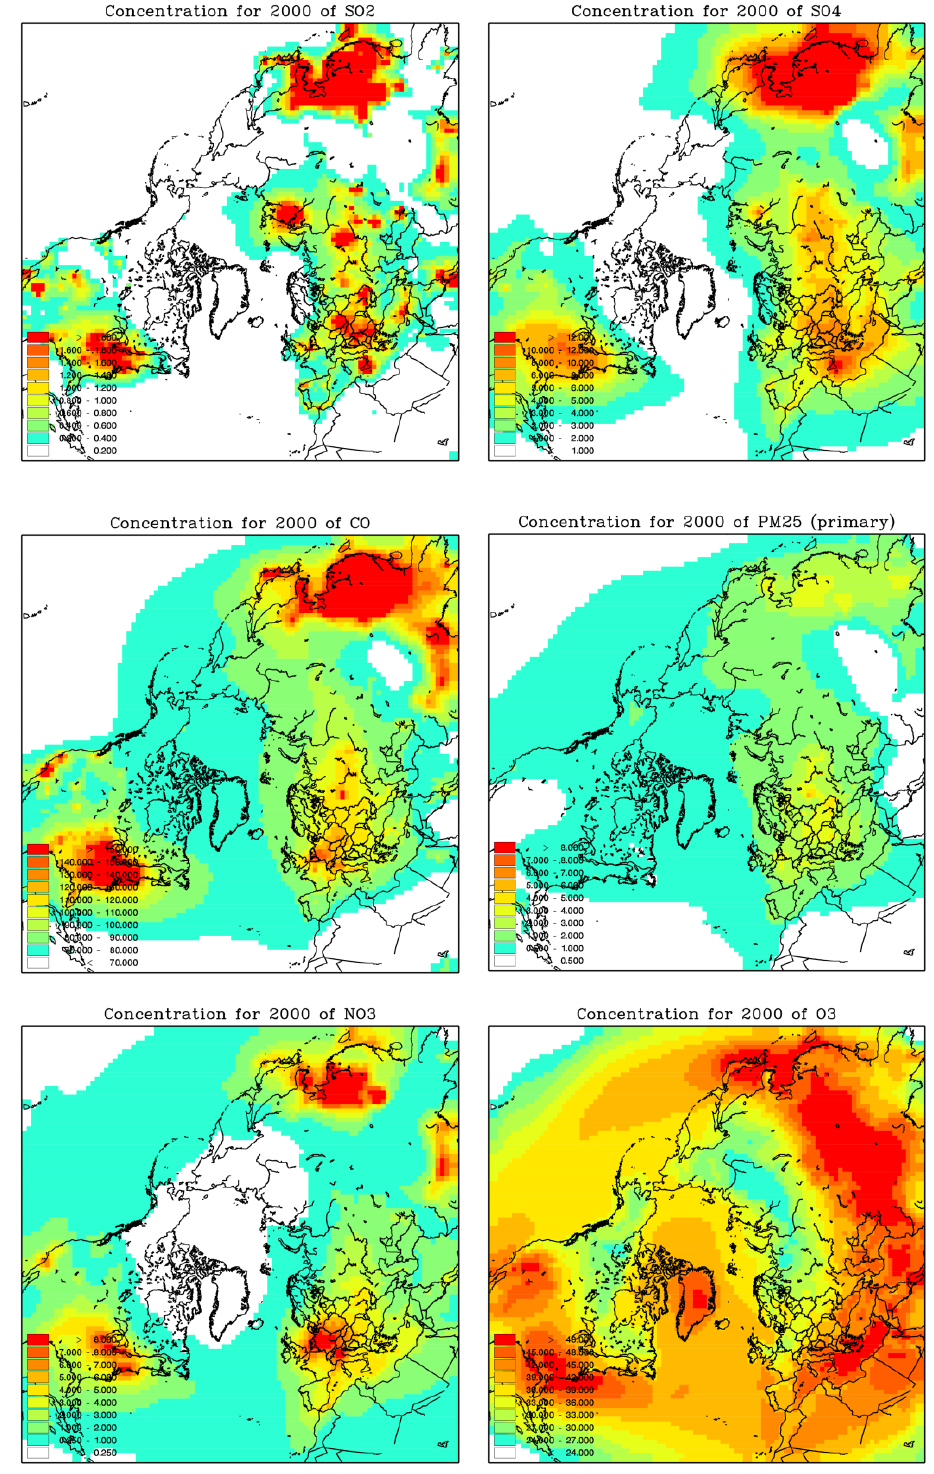
Fig. 1. Mean annual air pollution levels calculated using the DEHM model due to emission from the Northern Hemisphere for the year 2000. The compounds are SO 2 [ppb], SO 2 − [µgm − 3 ], CO [ppm], PM 2 . 5 (primary part) [µgm − 3 ], NO − 4 for the DEHM northern hemispheric